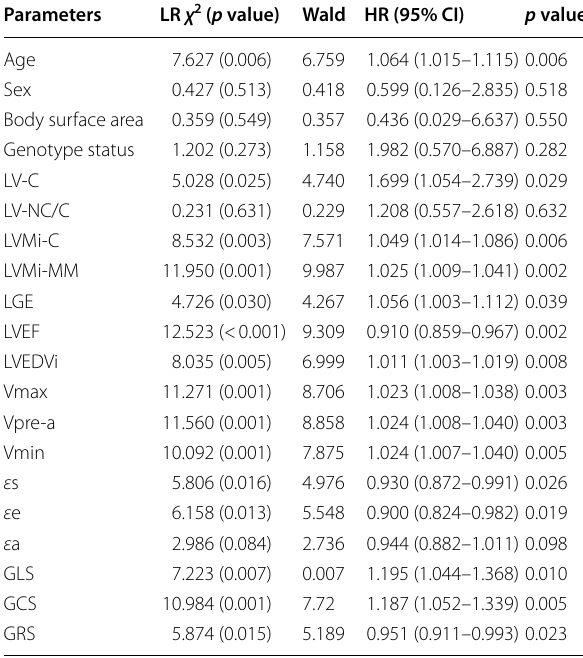
Table 4 Univariate Cox analysis for predicting primary endpoint during the follow-up